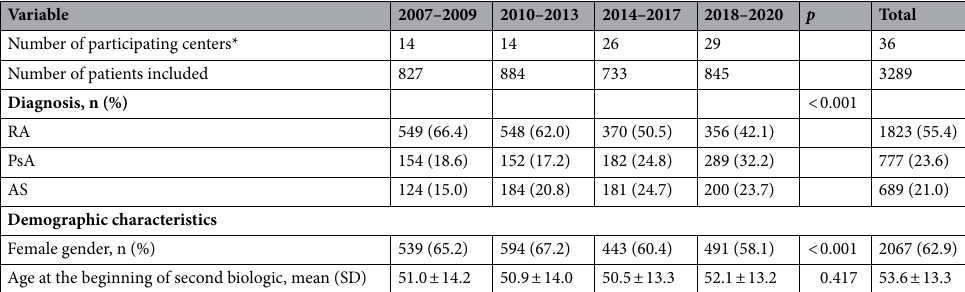
Table 3. Diagnosis and sociodemographic features at the beginning of a second biologic (second-line treatment) by time period. *Centers that included at least one patient in this analysis.